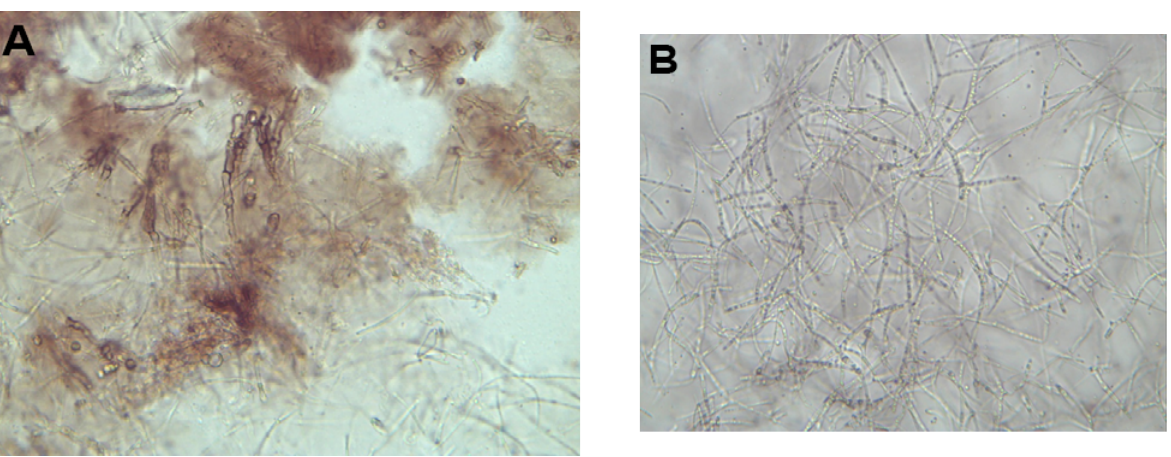
Fig. 3 Deformation of Diaporthe eres hyphae (strain 264J) growing on medium supplemented with Discus 500 WG at the concentra- tion of 10 g cm −3 ( A ) and the appearance of hyphae in the control ( B ) (photo B.